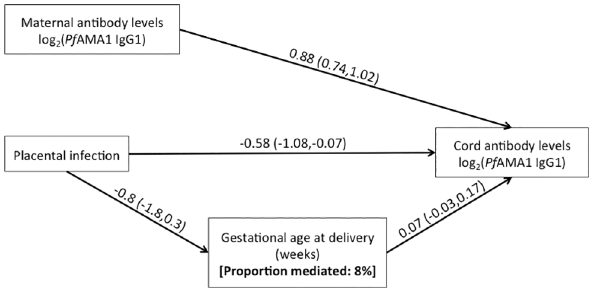
Fig 5. Path analysis model for cord PfAMA1 IgG1 levels and placental P . falciparum infection in primigravid women. Estimated mean difference (95% CI) are presented. For other antibodiessee S4 Table.